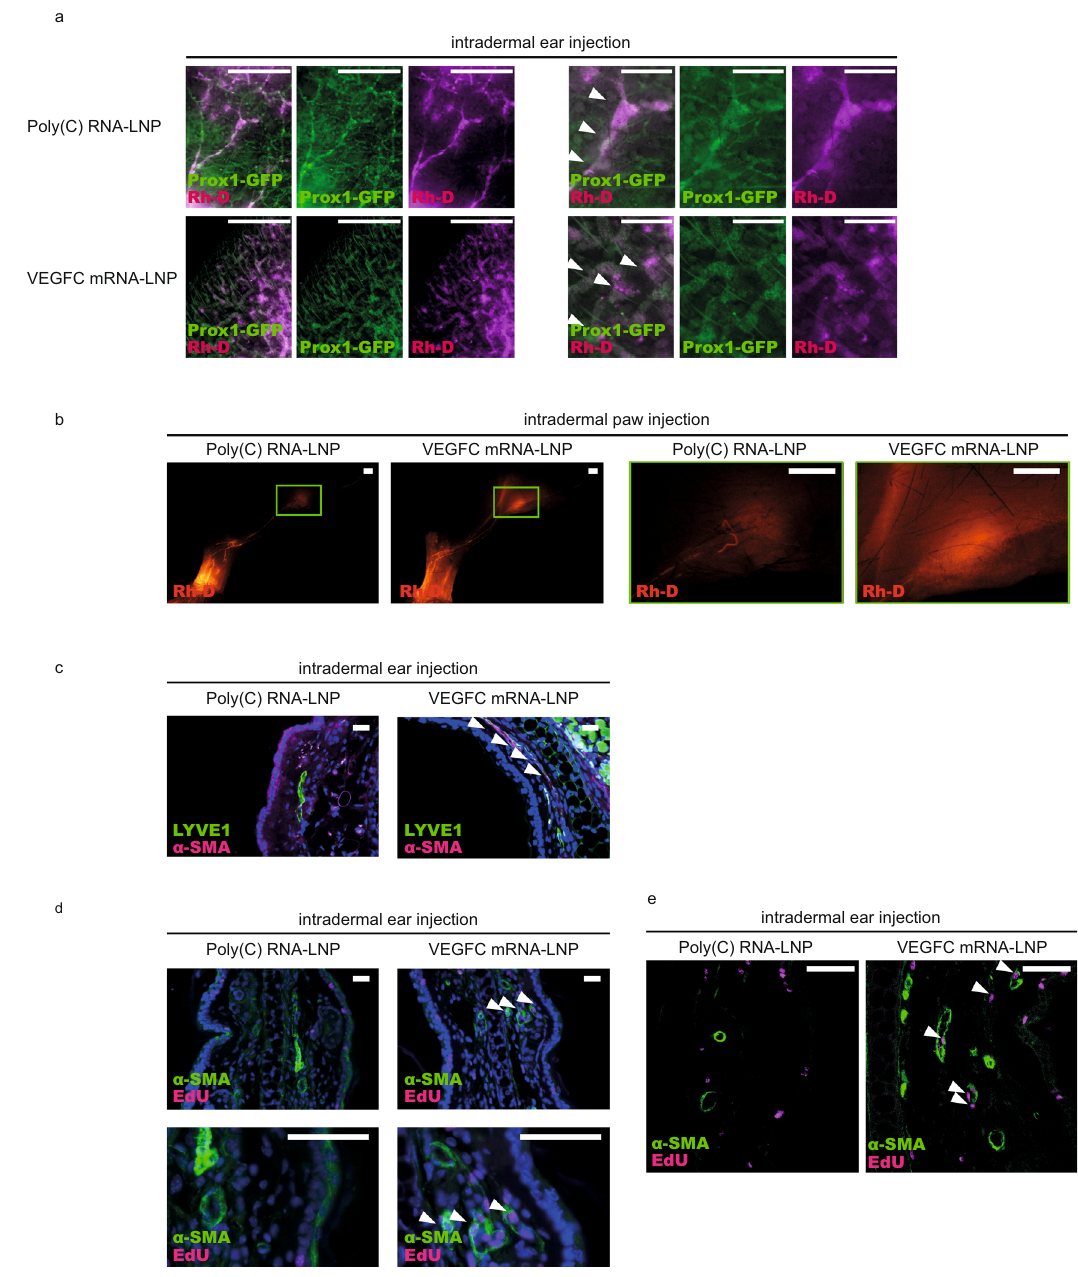
Fig. 6 Administration of VEGFC mRNA-LNPs stimulates active lymphatic function. a Monitoring active lymphatic function in the ears of Prox1 GFP mice after intradermal injection of 1 µ g of Poly(C) or VEGFC mRNA-LNPs. Twenty-two days after treatment, 70 kDa Rhodamine dextran (Rh-D) was injected into the ear and the transport of the molecule was monitored by fl uorescent microscopy 60 min post Rh-D administration. Representative images are shown of 10 injected mouse ears per group (bars, 1000 µ m). Arrows indicate Prox1-GFP positive and Rh-D positive lymphatic vessels. b Monitoring active lymphatic function in the paws of mice after intradermal injection of 1 µ g of Poly(C) or VEGFC mRNA-LNPs. Seventy- fi ve days after treatment, 70 kDa Rh-D was injected into the paws and the transport of the molecule was monitored by fl uorescent microscopy 90 min post Rh-D administration. Representative images are shown of 2 mouse hind limbs in each group (bars, 1000 µ m). Green rectangles show the magni fi ed area which represent the area of popliteal lymph nodes. c Analysis of lymphatic morphology in the ear of mice injected with 1 µ g of Poly(C) or VEGFC mRNA-LNPs. Representative images 22 days after the treatment of 3 mouse ears per group are shown by anti-LYVE1 and anti- α -SMA immunostaining of slides processed by paraf fi n-based histology (bars, 50 µ m). Arrows indicate LYVE1 low lymphatics surrounded by α -SMA positive cells. d – e Assessment of lymphatic proliferation 5 days after intradermal injection with 1 µ g of Poly(C) or VEGFC mRNA-LNPs. Representative images of 3 mouse ears are shown in each group with EdU staining and anti- α -SMA immunostaining of slides processed by paraf fi n-based histology (bars, 50 µ m) and shown by wide fi eld ( d ) and confocal imaging ( e ). Arrows indicate EdU positive cells surrounded by α -SMA positive cells. All cell nuclei are labeled with DAPI (blue) in paraf fi n-embedded